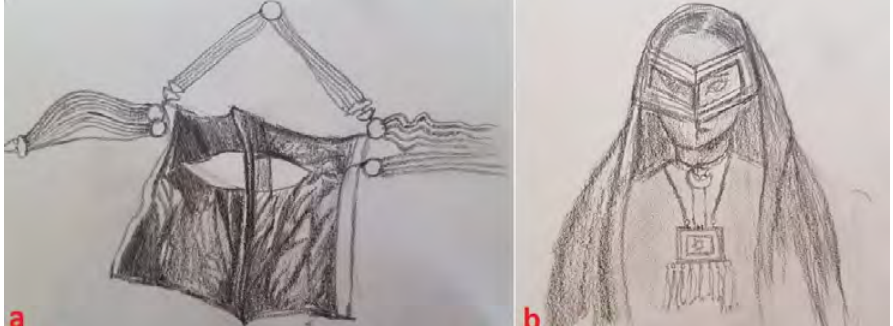
Figure 1. Omaniancient Bedouin burqa (a) embroidered with silver filament and decorated withsilver sequins; Omani ancient Saif Malik burqa face mask embroidered withsilver (b). Drawings by Osman L,